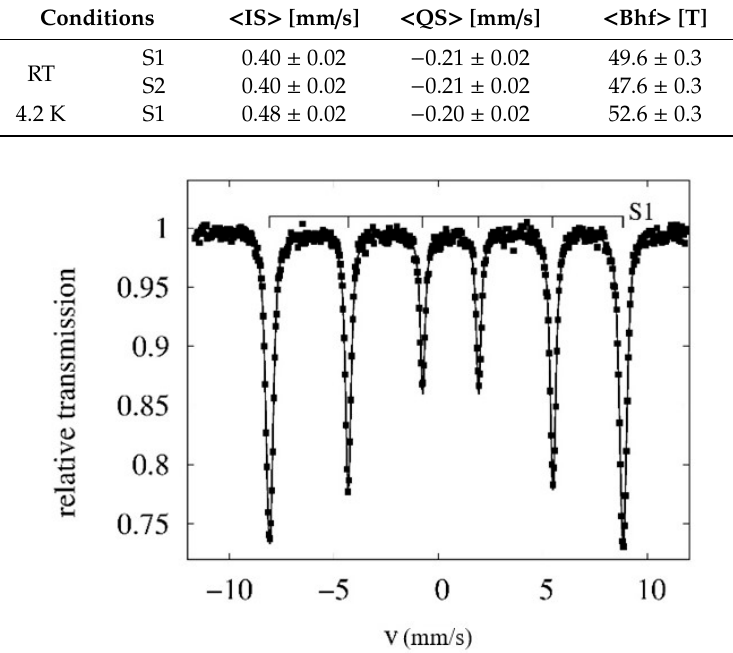
Table 5. Hyperfine parameters of the sample EAFS*.